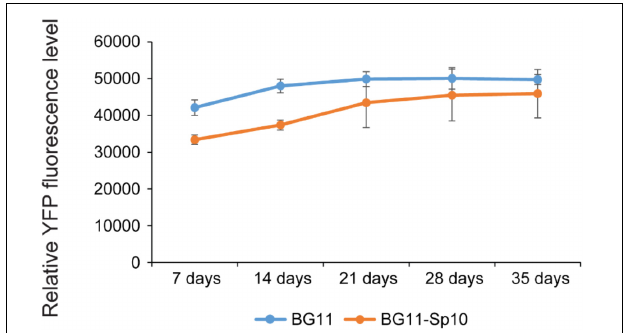
FIGURE 4 | pSCB-YFP plasmid maintenance without antibiotic selection over time based on YFP fluorescence. In order to assay pSCB-YFP stability in the absence of antibiotic selection pressure, SCB-YFP exconjugants were grown in BG11 medium supplemented with 10 µ g/ml Sp antibiotic for 7 days. This was used as seed culture for further inoculation into two different kinds of medium with an initial OD 730 = 0.1. One was BG11 medium supplemented with 10 µ g/ml Sp, the other was BG11 medium lacking antibiotics. These were grown under defined conditions as described in “Materials and Methods” and then assayed for YFP fluorescence. Syn6803M strain grown in BG11 medium to the same stage was used as negative control. The fluorescence assay showed that YFP fluorescence levels did not decline in any of the treatments. SCB-YFP even showed slightly higher fluorescence level in antibiotic-free medium (BG11 in blue color) than in BG11 medium supplemented with Sp10 (BG11 + Sp in orange color) during first 2 weeks. There was no significant fluorescence level difference between the two treatments during a 5-week period. Error bars represent standard derivation from three biological replicates which were taken from three independent cultures growing side by side and three technical